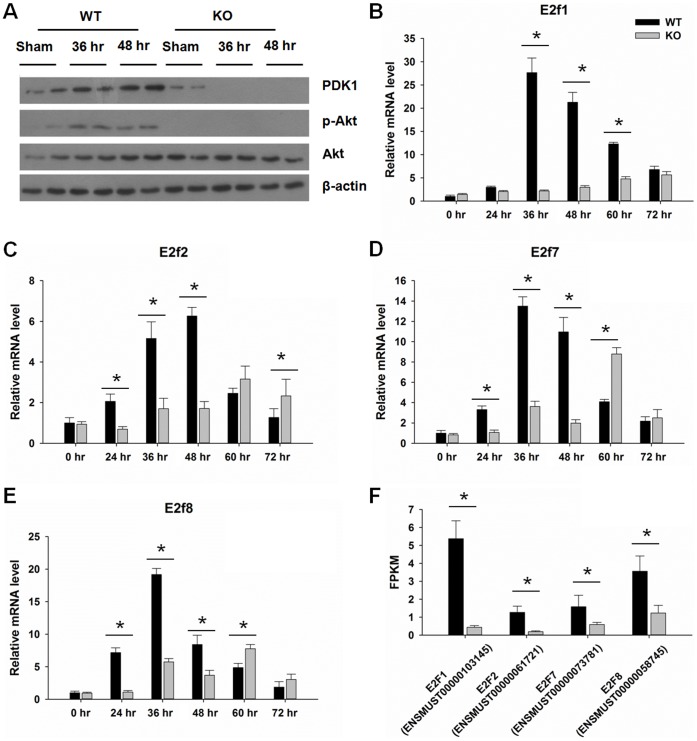
Western blot for PDK1/Akt pathway and gene expression of E2fs.(A) Protein levels of the PDK1/Akt pathway in wild-type (WT) and PPARβ-null (KO) mice. Hepatic gene expression levels of (B) E2f1, (C) E2f2, (D) E2f7, and (E) E2f8 over a time course from 0 to 72 hours after PH by qPCR (n = 3). (F) Differential analysis results for E2fs. Expression plot shows clear differences in the expression of E2f1, 2, 7, 8 between KO versus WT mice, measured in fragments per kilobase of exon per million fragments mapped (FPKM). Expression of a transcript is proportional to the number of reads sequenced from that transcript after normalizing for that transcript’s length. Means ± SD are graphed. * p<0.05.